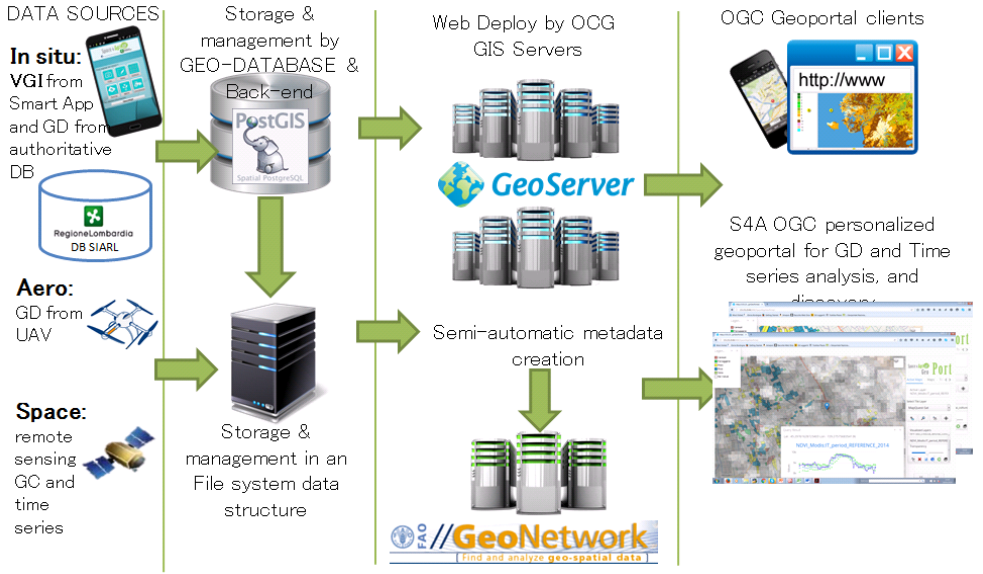
Figure 1. Architecture of the Space4Agri (S4A ) Spatial Data Infrastructure (SDI).